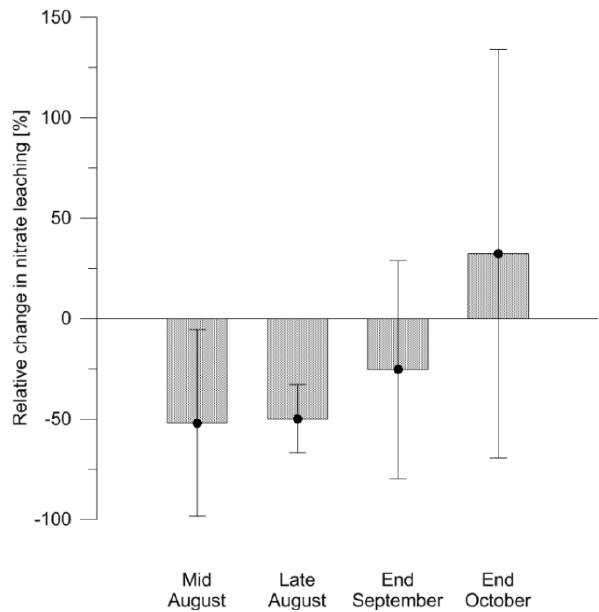
Figure 2. Effect of sowing date of catch crops on nitrate leaching during winter relative to no catch crop sowing